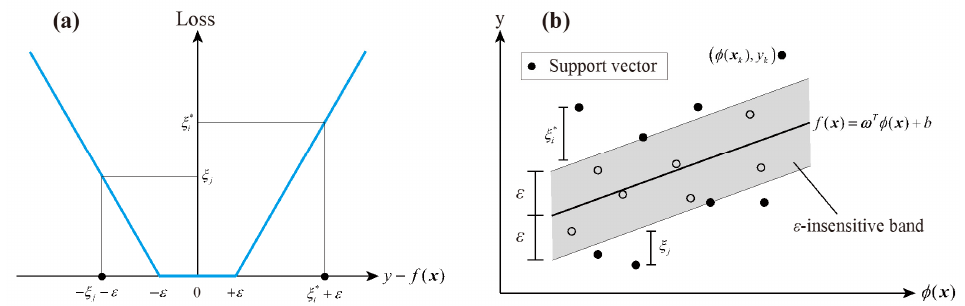
Figure 4. Illustration of ( a ) ε -insensitive loss function and ( b ) support vector regression in the feature space.